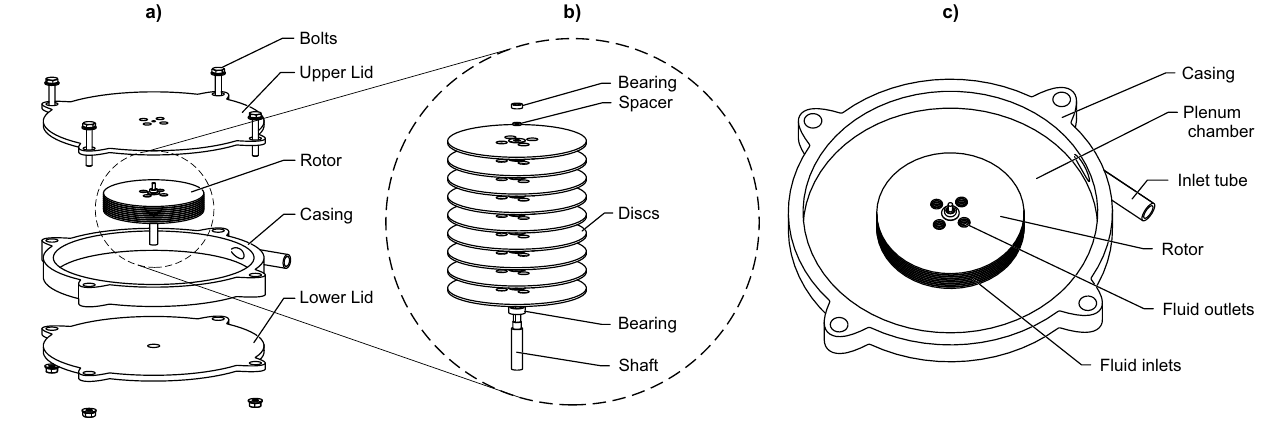
Figure 2. Tesla turbine design. ( a ) Top level components. ( b ) Detail view of the rotor. ( c ) Fluid